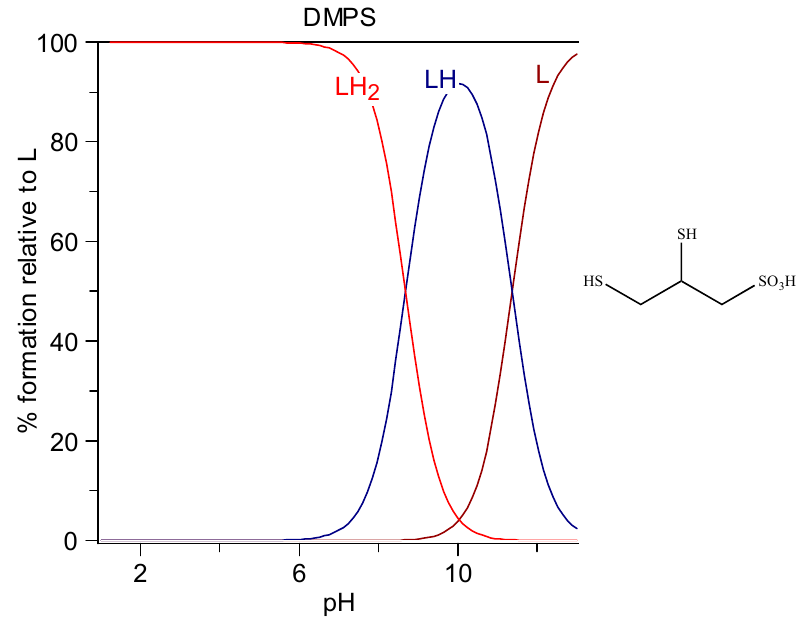
Figure 5. Speciation plots of DMPS.